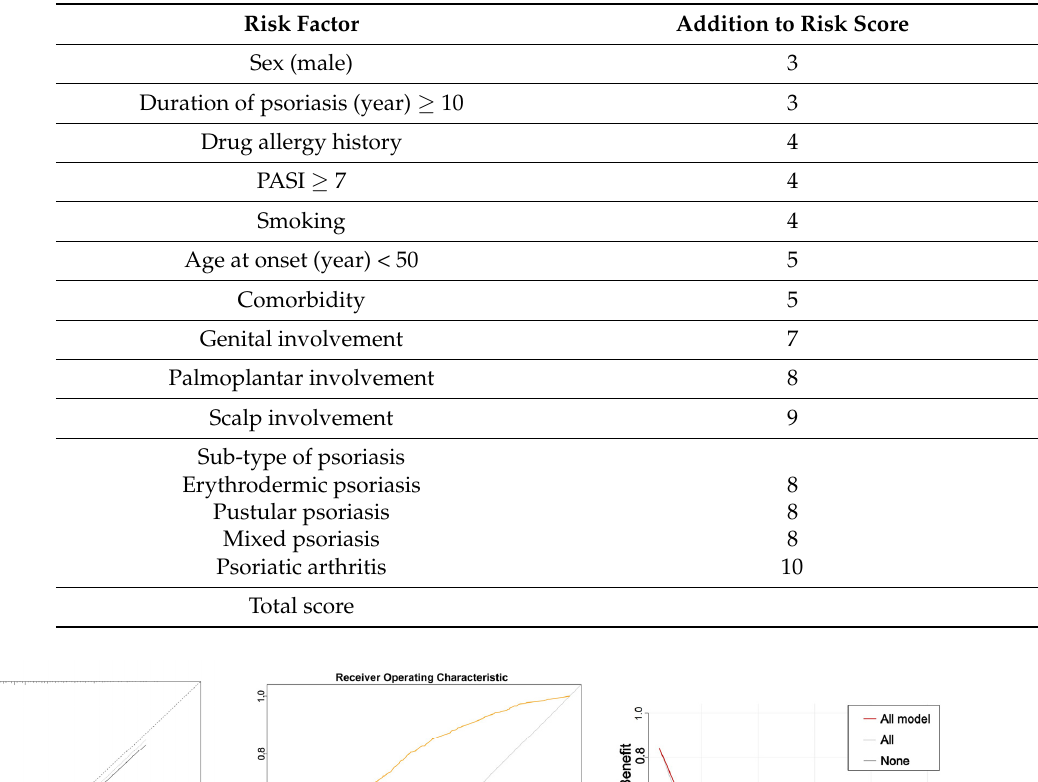
Table 4. A simple scoring questionnaire to predict psoriatic nail damage based on nomogram. The total score is 86, higher scores indicate a higher risk of nail damage.